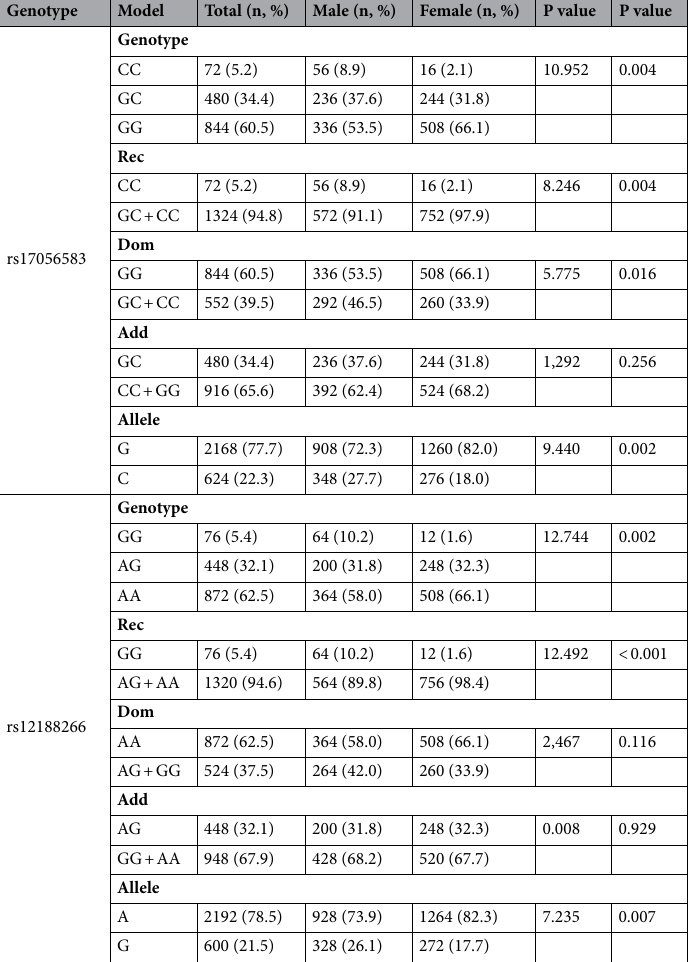
Table 2. Distribution of SNPs of RNF145 gene for study